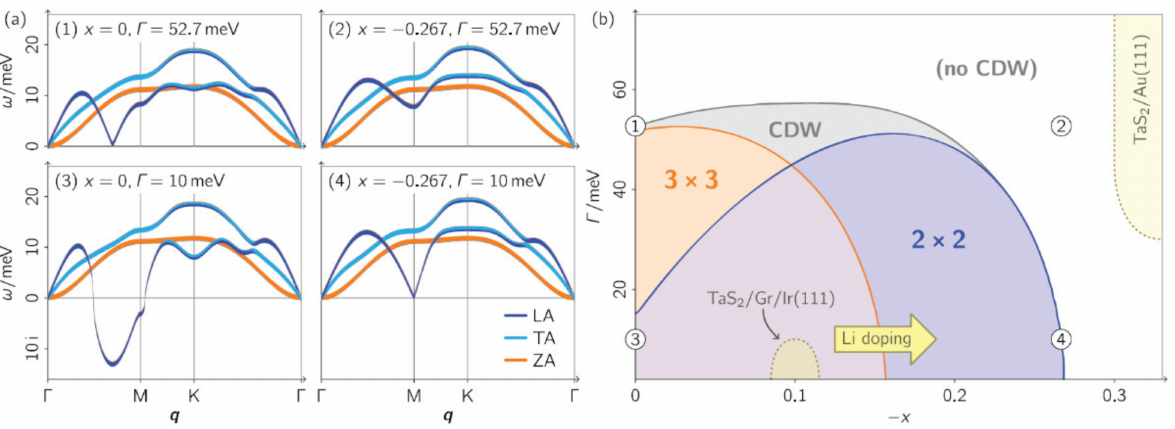
Figure 13. ( a ) Phonon dispersions and lattice instabilities of monolayer TaS 2 under different electronic conditions at 0 K (calculated). Acoustic phonon dispersions for different levels of hybridization with the substrate Γ (half width at half maximum of the electronic broadening) and charge doping x (electrons per Ta atom); x < 0 refers to electron addition. The character of the phonon modes, i.e., longitudinal (LA), transverse (TA), or out-of-plane (ZA), is marked in color. Imaginary phonon mode energies indicate that the lattice is unstable toward corresponding periodic lattice distor- tions. ( b ) Phase diagram of lattice instabilities in monolayer TaS 2 . The CDW region is defined by the presence of an imaginary phonon energy. Regions with instabilities are shaded in color. Some experimentally realized situations are in the phase diagram. Reprinted with permission from Reference [134]. Copyright 2018 by the American Chemical